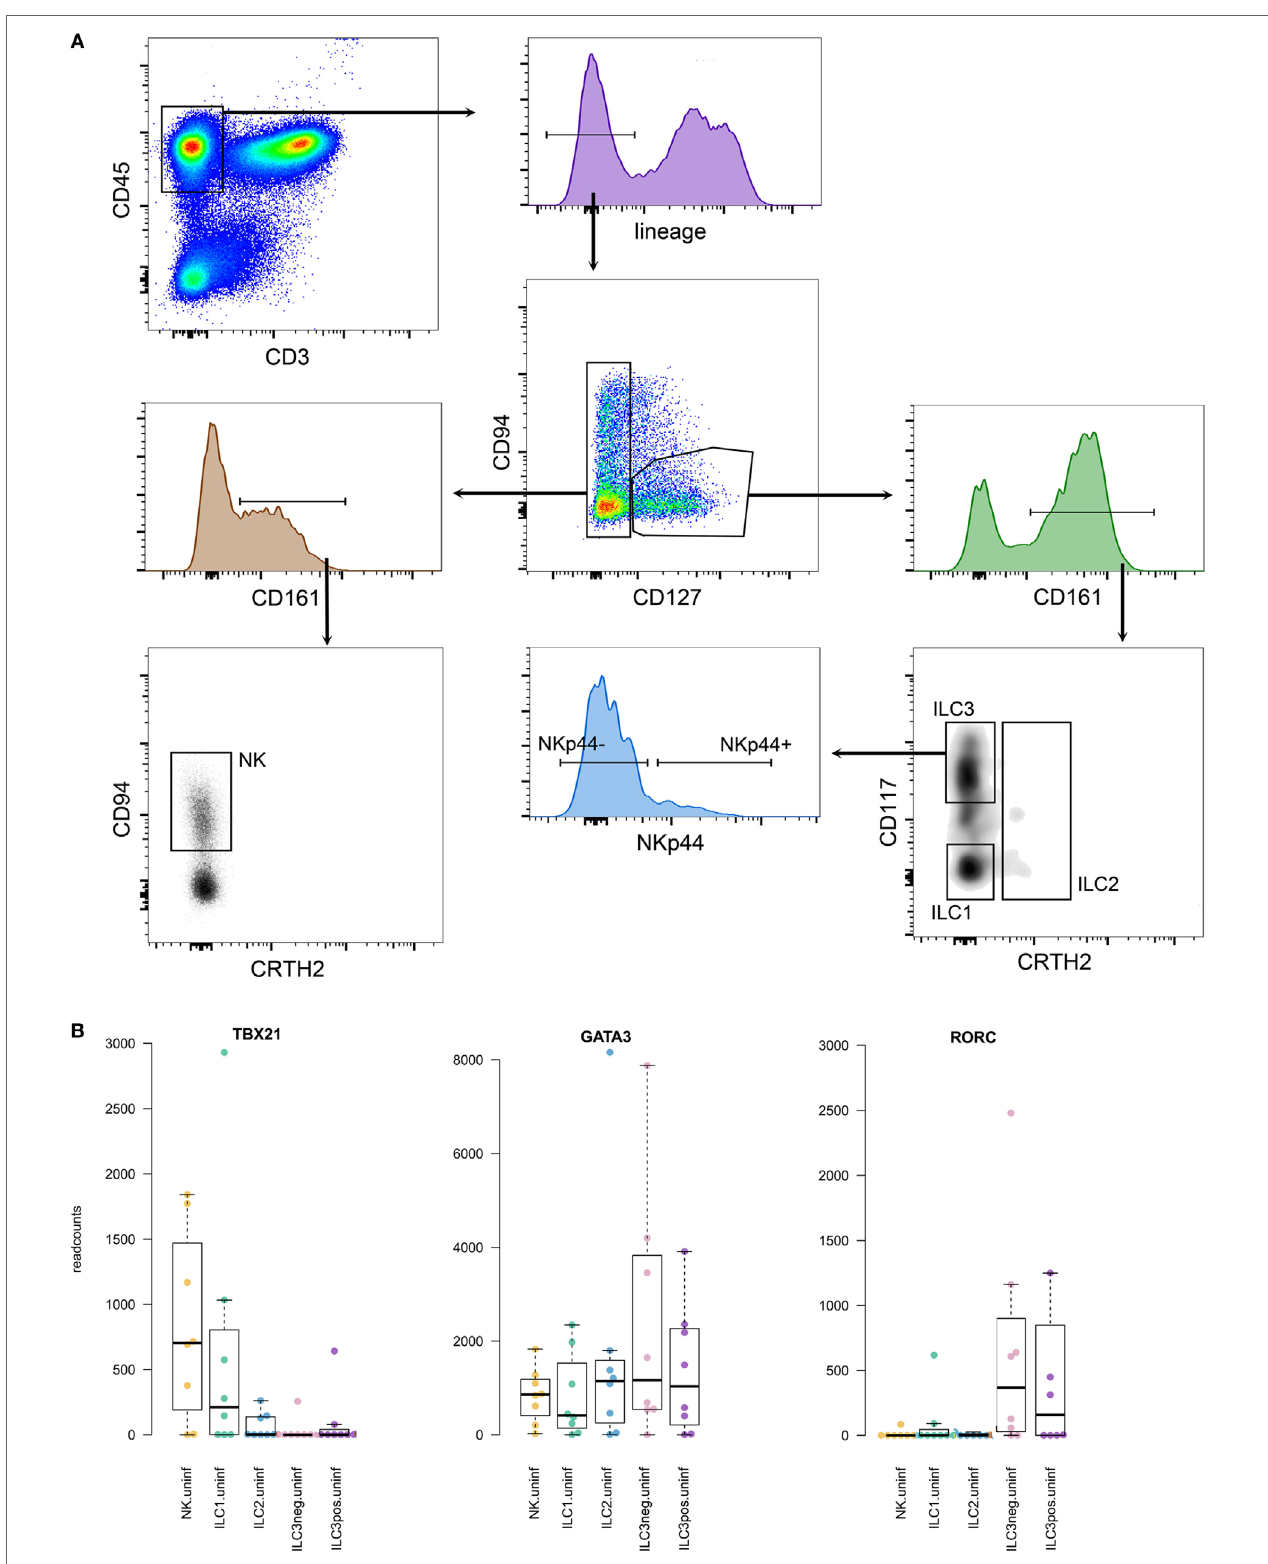
FigUre 5 | (a) Gating strategy for innate lymphoid cells (ILCs), gated on lymphocytes in forward-side scatter. (B) Expression levels of prototypic transcription factors in the different ILCs